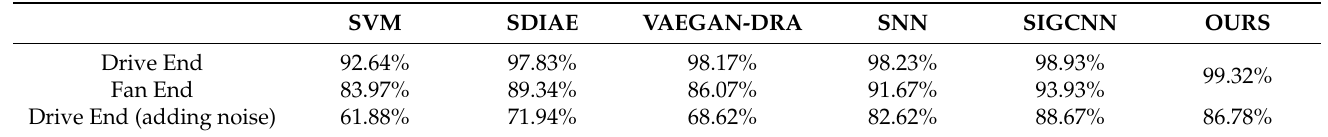
Table 4. Prediction accuracy comparison.